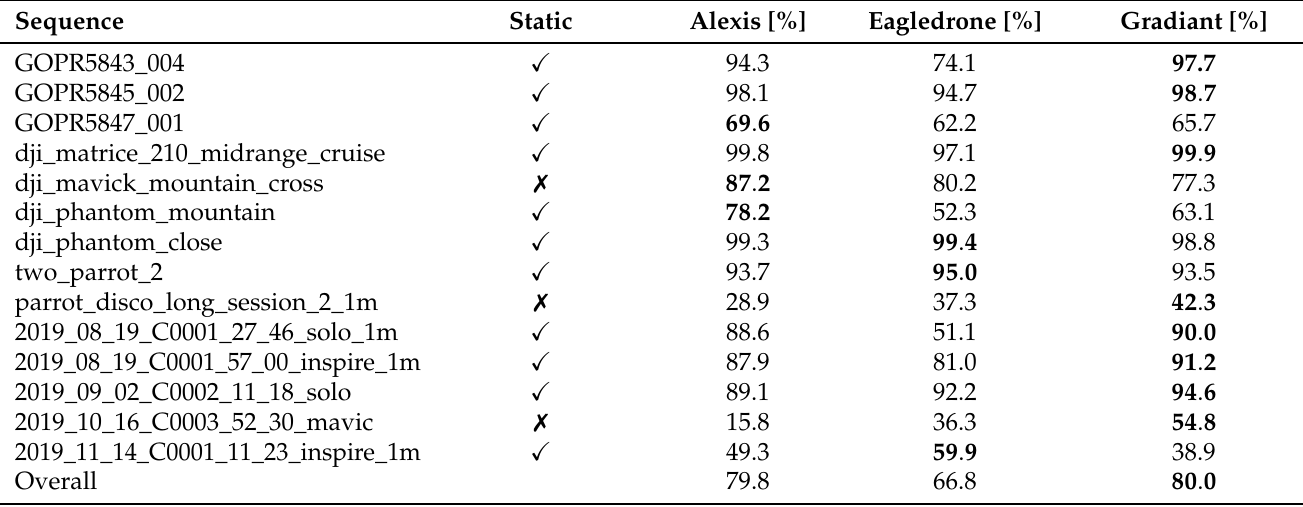
Table 5. Detailed comparison best run for each team in the Drone vs. Bird Detection Challenge 2020. The first column denotes static or moving camera. The evaluation metric used for this dataset is AP. The evaluation is given for every sequence of the test set. The overall averaged result is given at the bottom. Sequence Static Alexis